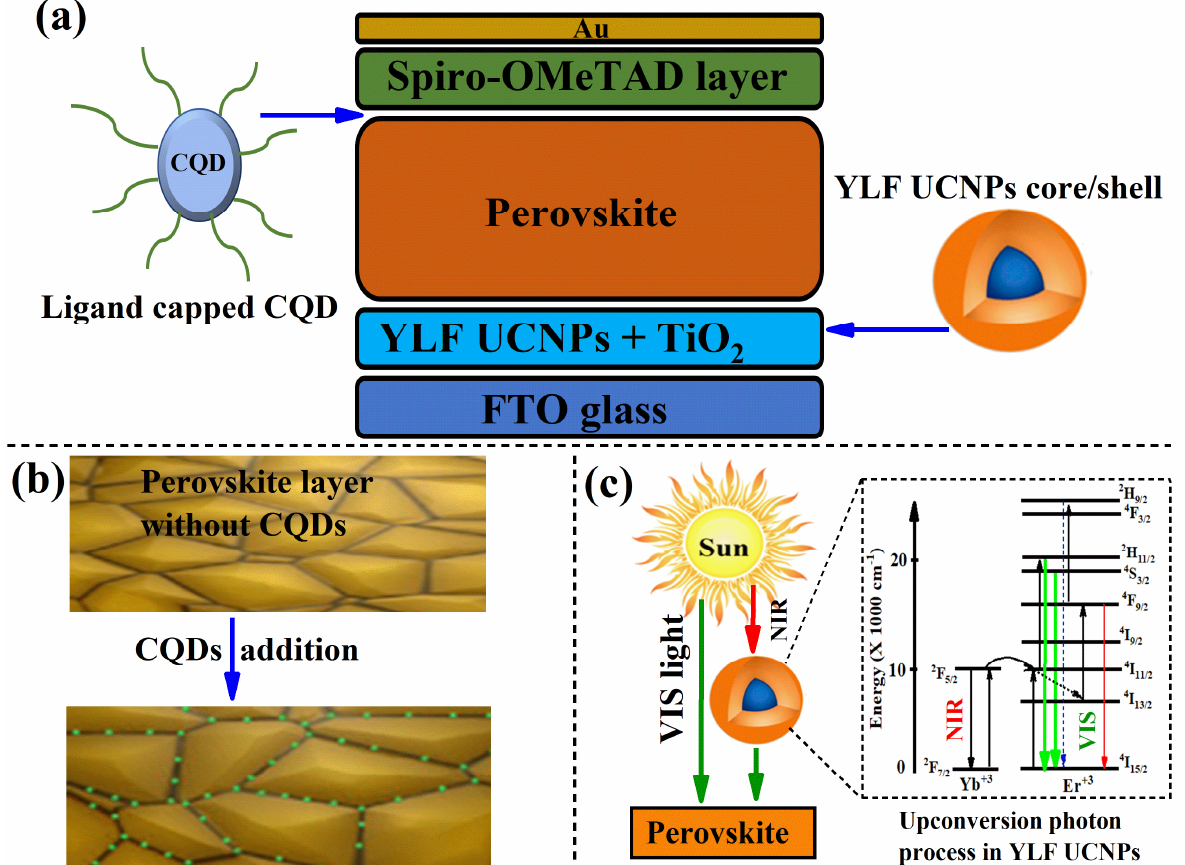
Figure 1. ( a ) Schematic diagram of the PSC layers where the ligand-capped CQDs are mixed at different concentrations with the perovskite layer, while the UCNPs are embedded in the mesoporous layer. ( b ) Illustration diagram of the proposed passivation mechanism of CQDs in the PSC devices. ( c ) Schematic diagram of the upconversion process of converting wasted NIR photons of sunlight to visible light by the UCNPs.